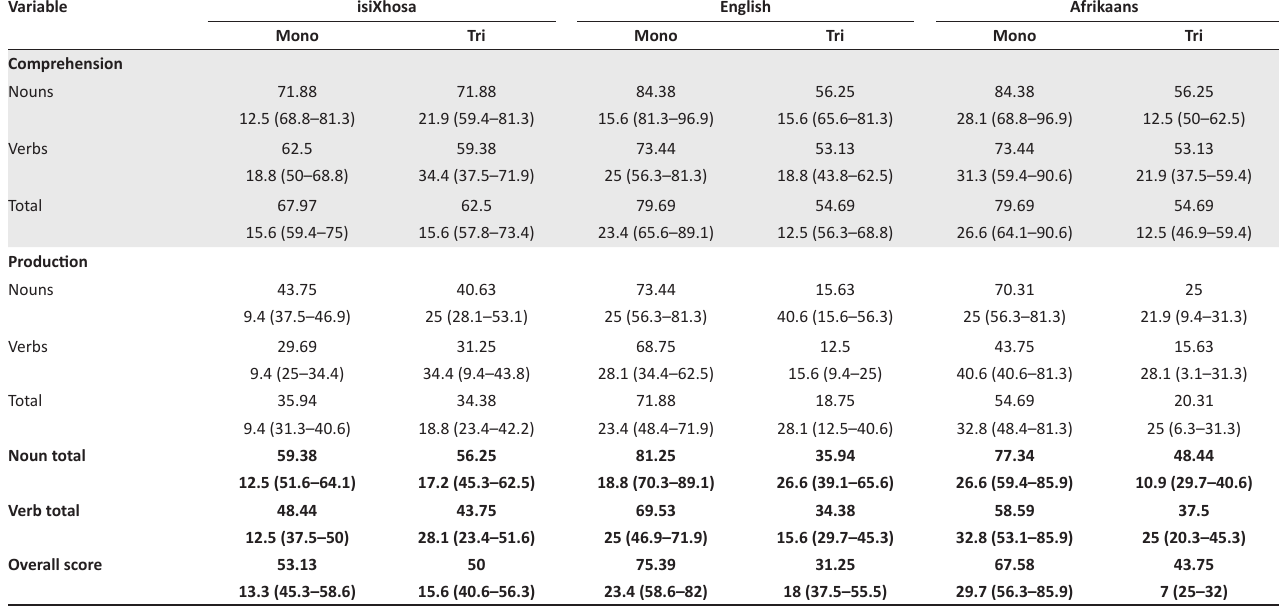
TABLE 2: Monolinguals’ ( n = 10 per language group) versus trilinguals’ ( n = 11) median scores on the LITMUS-CLTs, as percentages with IQR below it. Variable